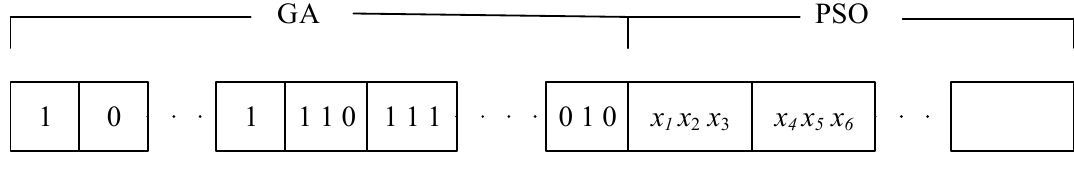
Figure 6. The adjustable parameters of the chromosome.